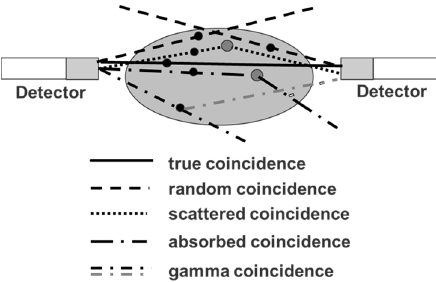
Figure 4. Schematic representation of photon-coincidences. A true coincidence is recorded, if the two annihilation photons from one positron emission hit opposing detectors without interaction. All other coincidences are false and disturb the PET measurement. A gamma coincidence occurs if one annihilation photon from a positron emission and a simultaneously emitted cascade gamma photon hit opposing detectors.